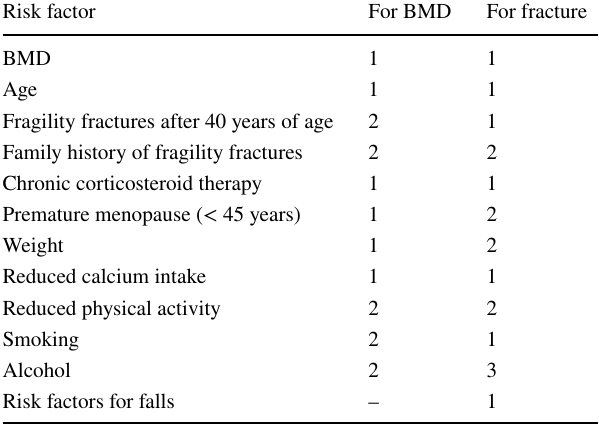
Table 4 Risk factors for low BMD and fragility/low-energy frac- tures: levels of evidence are also shown (level 1: evidence from RCTs or metanalyses of RCTs; level 2: evidence from prospective cohort studies or poor-quality RCTs; level 3: evidence from case–control studies or retrospective cohort studies). Reproduced (with permis- sion) from Table 1 of Guidance for the diagnosis, prevention and therapy of osteoporosis in Italy (Cianferotti and Brandi